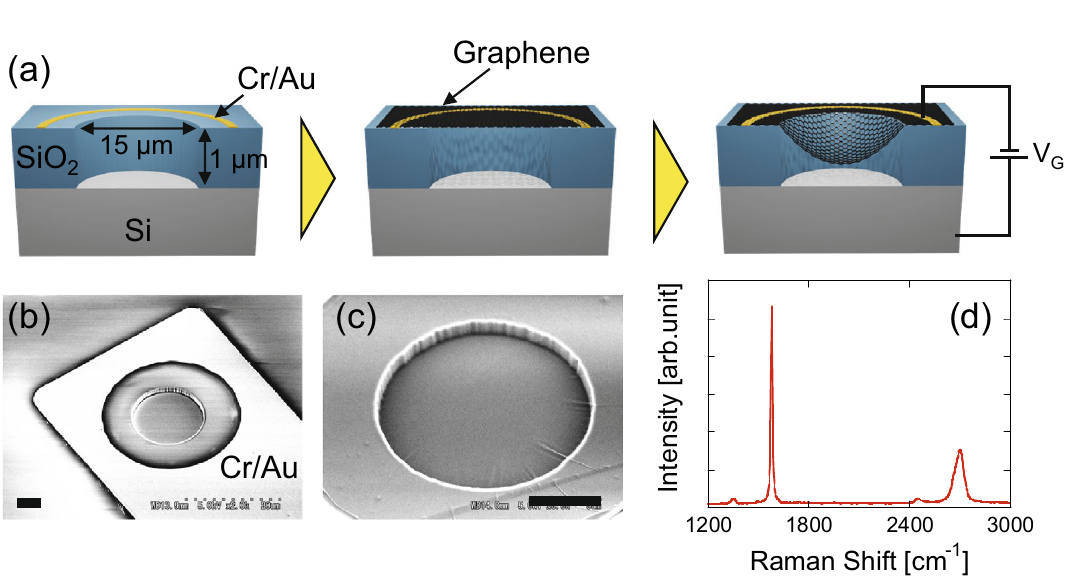
Figure 2. ( a ) Cross-sectional illustration of introduced strain by the electrostatic attraction in the device structure for DEVICE 2. Scanning electron micrographs of the hole fabricated in the substrate ( b ) before and ( c ) after graphene transfer. Bars represent 5 μm. ( d ) Typical Raman spectrum of graphene used for DEVICE 2, showing multilayer graphene with negligible